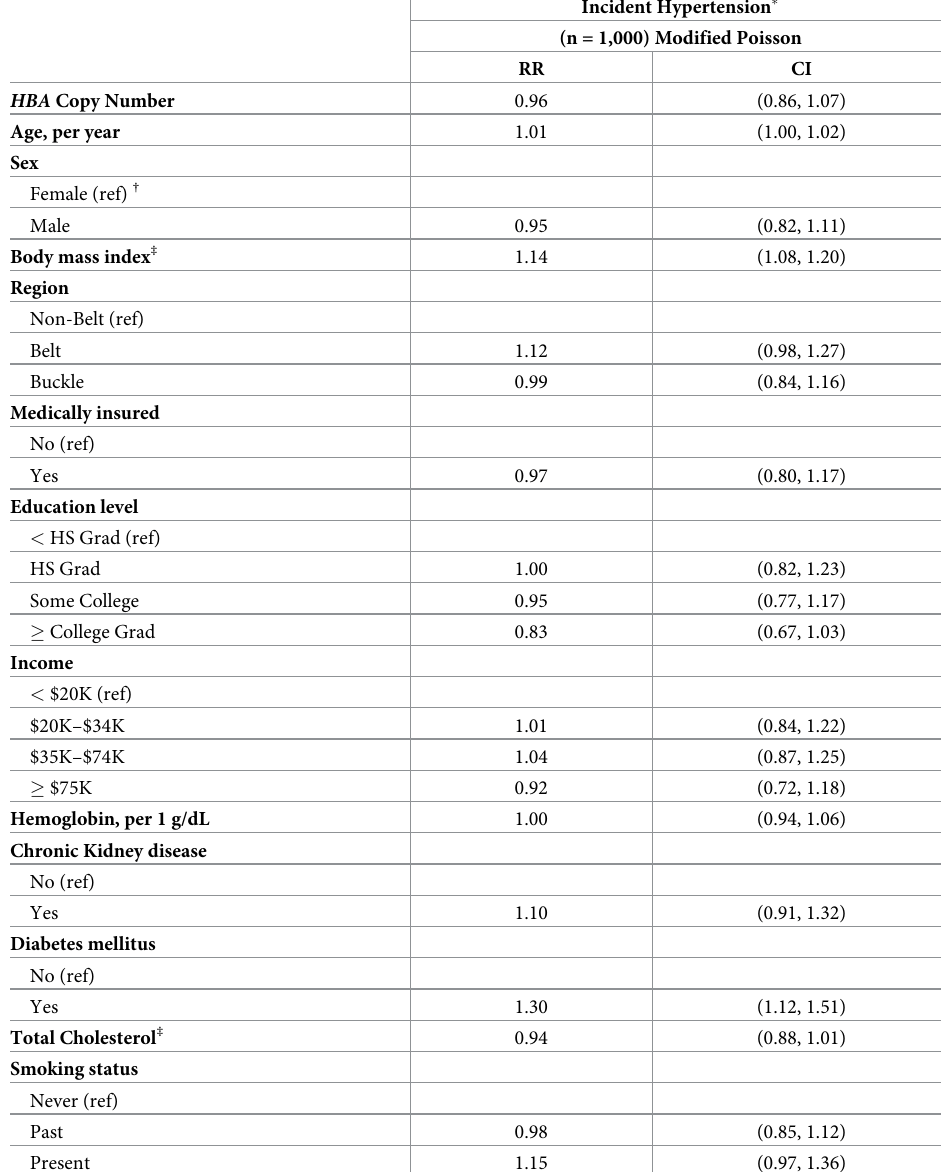
Table 3. Association of HBA copy number with incident hypertension–fully adjusted